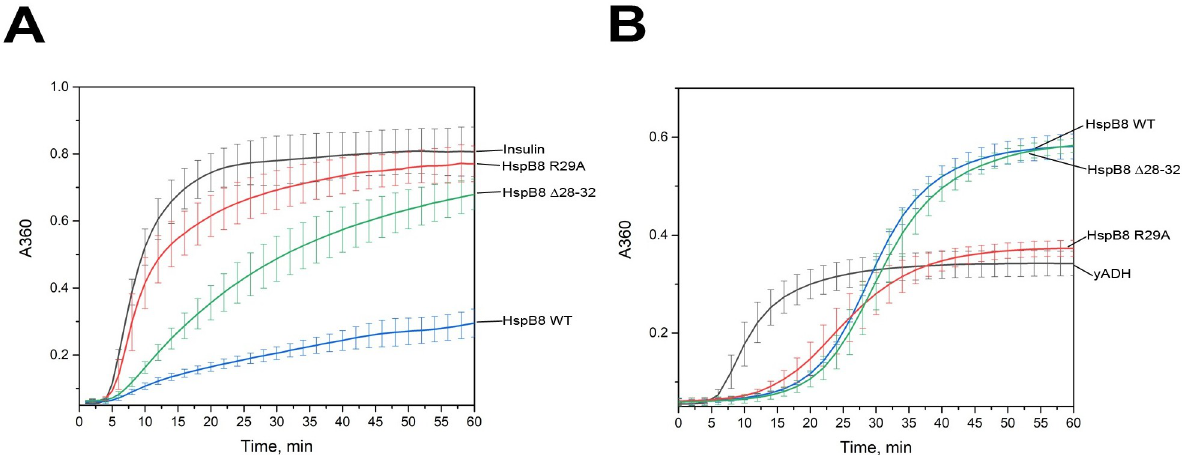
Fig 7. Chaperone-like activity of HspB8 WT and its mutants. A. Effect of HspB8 WT (blue), the R29A (red) and Δ 28–32 (green) mutants on DTT- induced aggregation of insulin. B. Effect of HspB8 WT (blue), the R29A (red) and Δ 28–32 (green) mutants on the heat–induced aggregation of yeast alcohol dehydrogenase (yADH). Data are representative of at least four independent experiments with error bars corresponding to standard deviation.